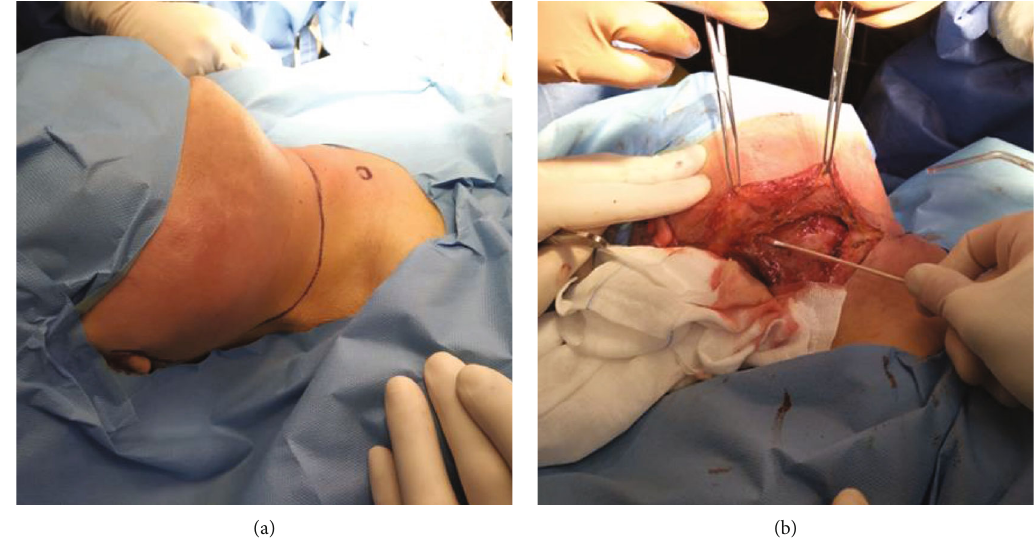
Figure 6: (a, b) Emergency surgery at ER: surgical procedure preparation (a); laterocervical abscess drainage (b).